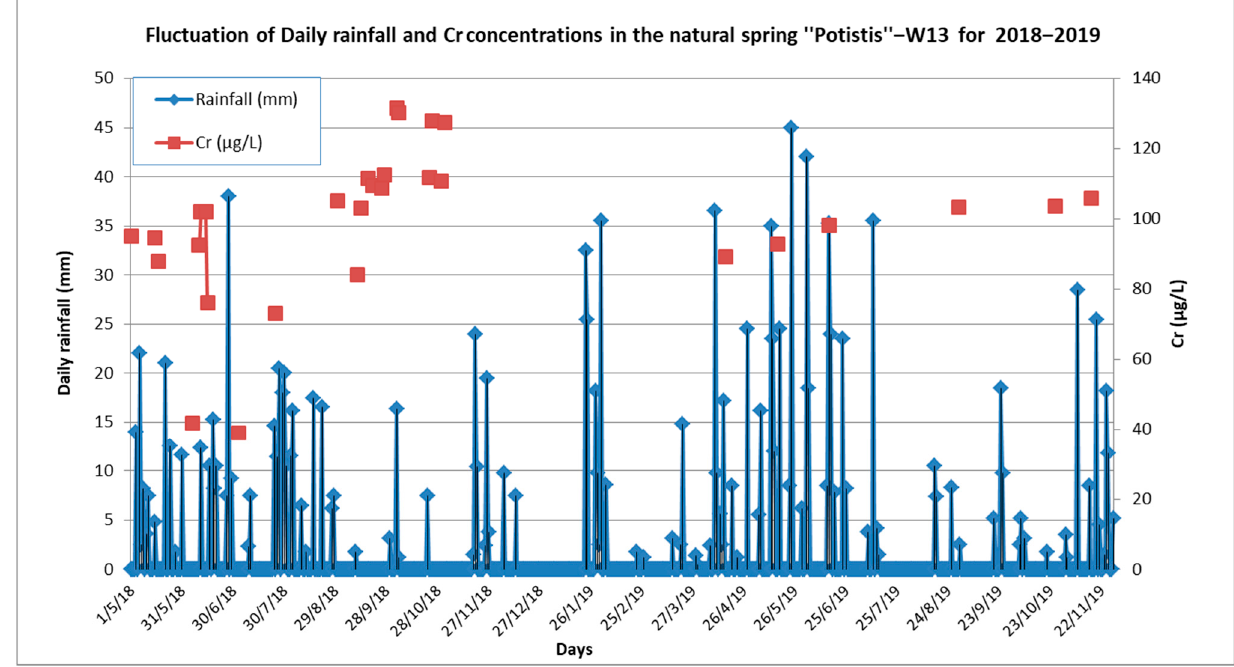
Figure 15. Average concentrations of Cr vs. water types of the natural springs in western Vermio Mt.